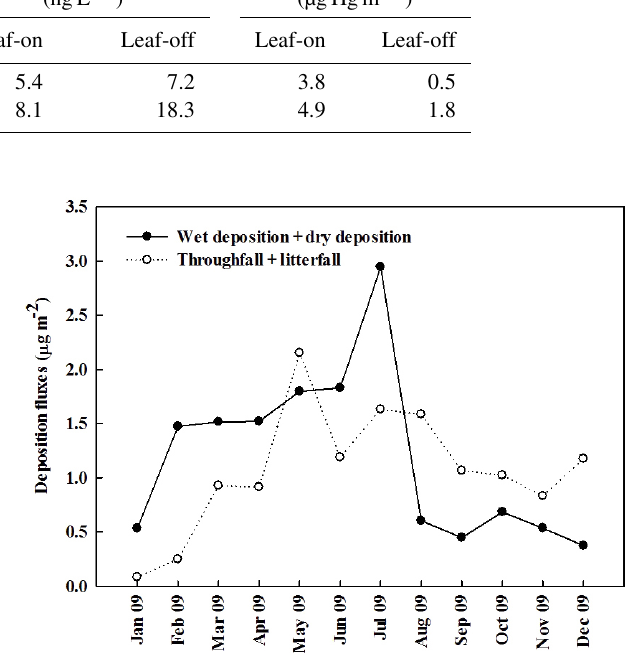
Figure 6. Comparison of deposition flux calculated by